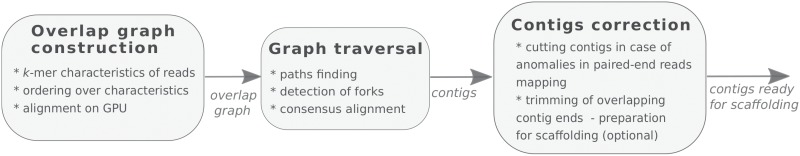
Diagram of the GRASShopPER assembler.The method has three main steps: construction of the overlap graph, its traversal, and correction of contigs.